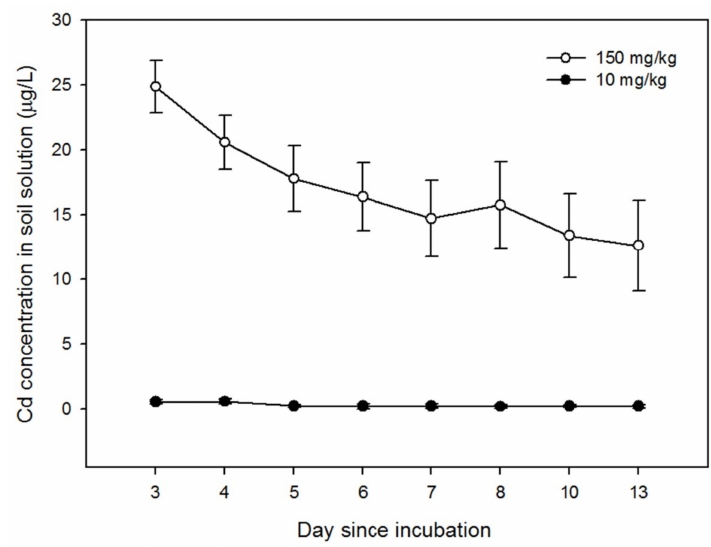
Figure 2. Cd aging curve in the alkaline soil used in this study. Soil solution was sampled ( n = 3) once a day since the third day post-incubation until the soil solution Cd tended to be stable.